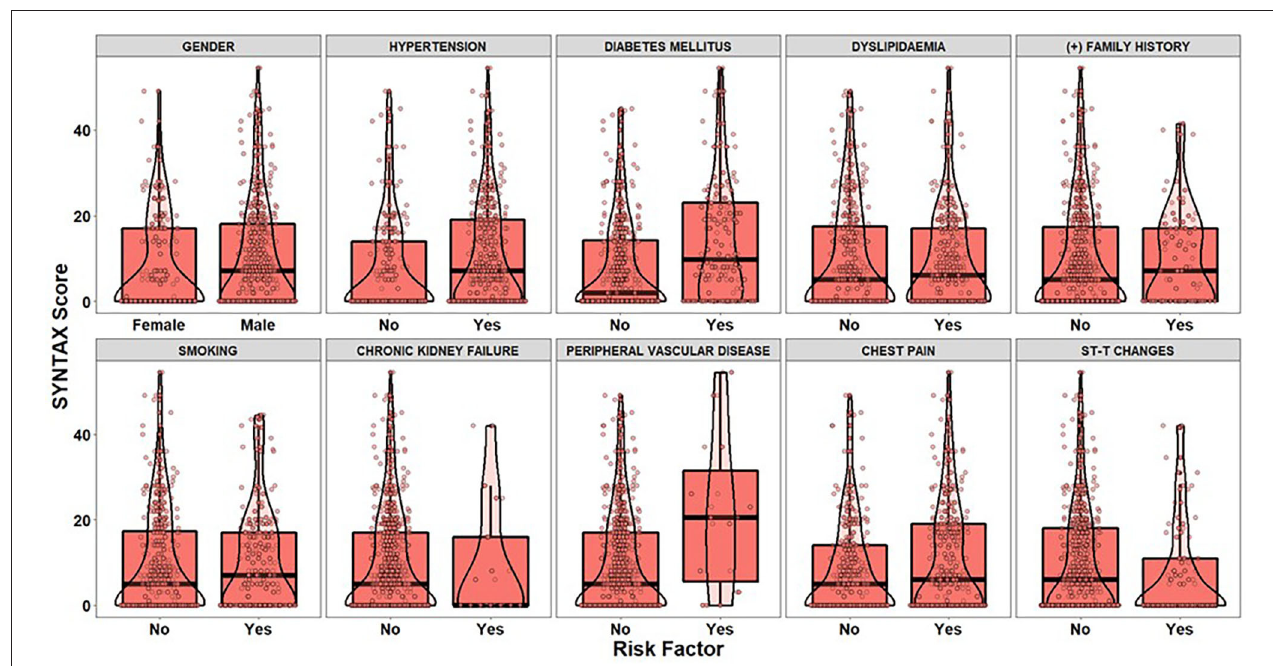
FIGURE 2 | The boxplots and violin plots represent the distributions of the SYNTAX score of patients (dots) for each level of categorical risk factor.